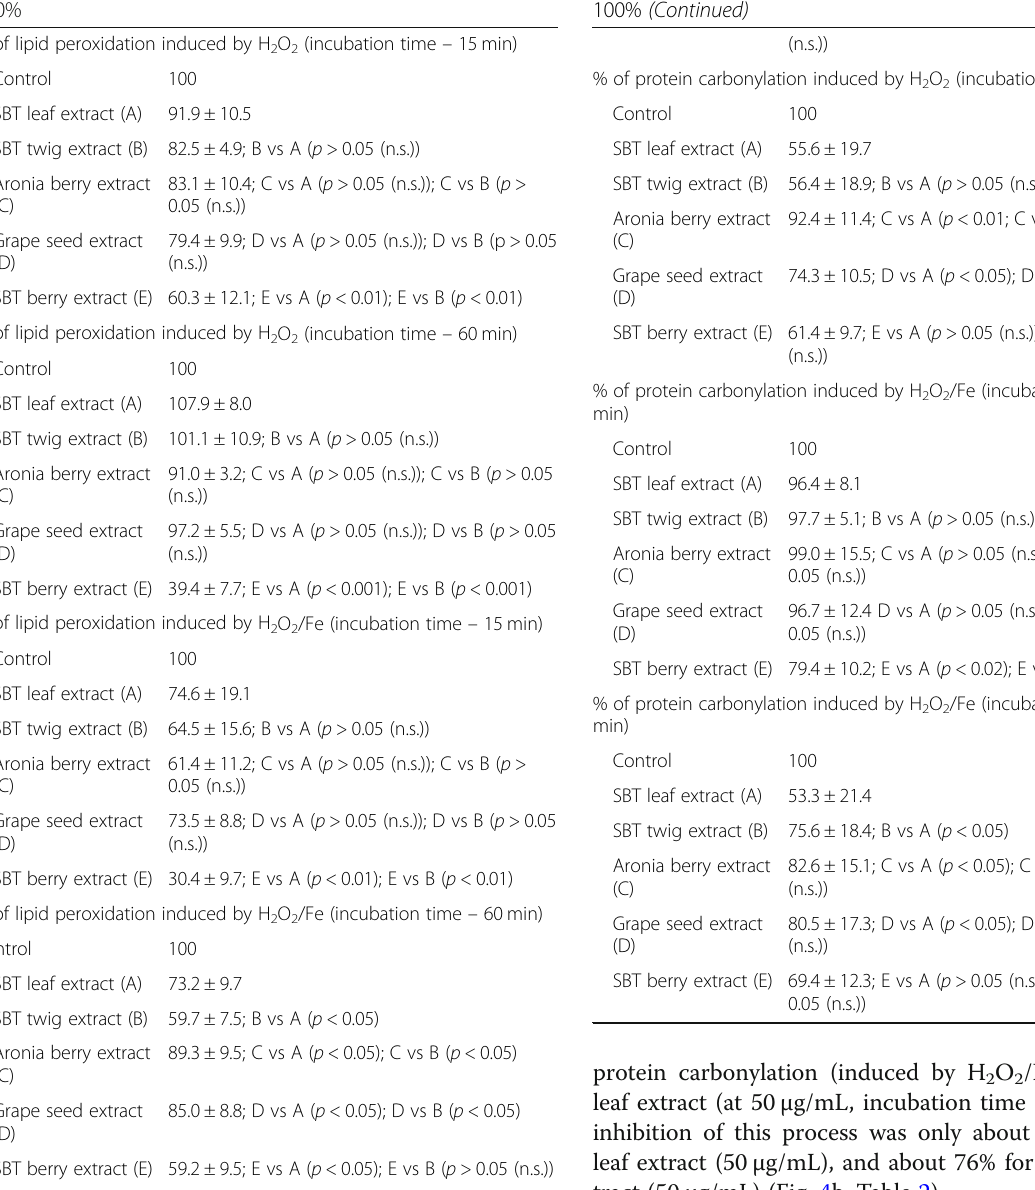
tract (50 μ g/mL) (Fig. 4b, Table 2). oxidation of plasma protein thiols demonstrated that SBT twig extract and leaf extract did not affect the said process (Fig. 5).